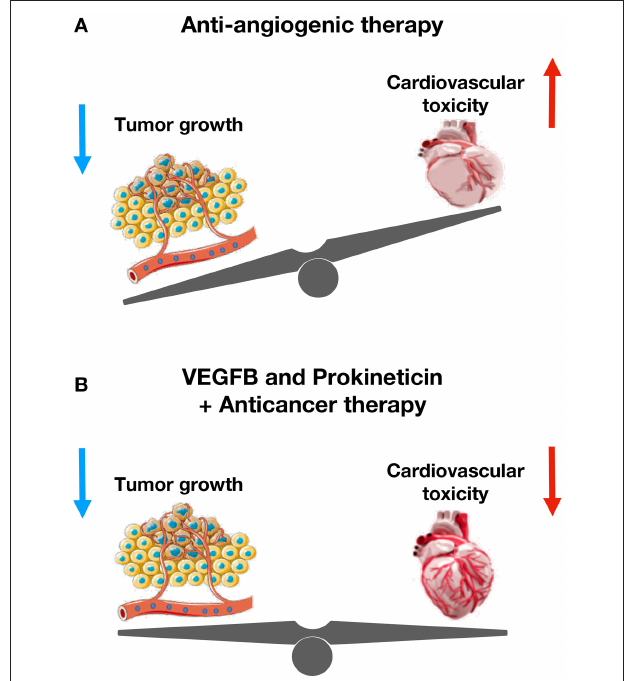
FIGURE 5 | The cardioprotective role of VEGFB and prokineticin against anti-cancer drugs-mediated cardiovascular toxicity. (A) Anti-angiogenic therapy reduces tumor size and increases cardiovascular toxicity. (B) VEGFB and Prokineticin receptor agonist protects cardiovascular system without altering anti-tumor effect of